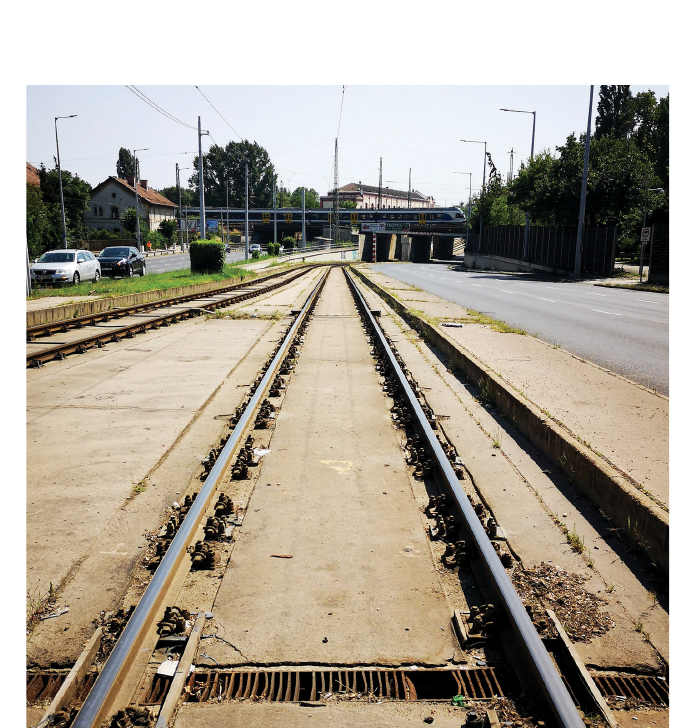
Figure 9. Section 1, 2021 (authors’ photo)